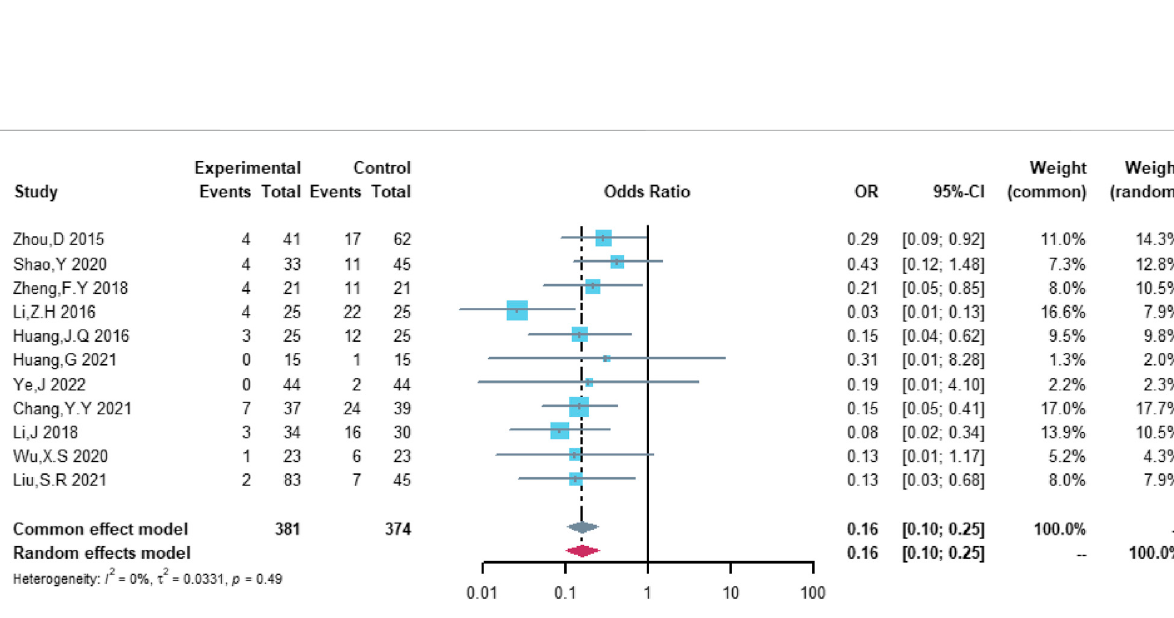
FIGURE 8 Changes in total cardiovascular adverse events in (R)-CDOP vs. (R)-CHOP treatment.